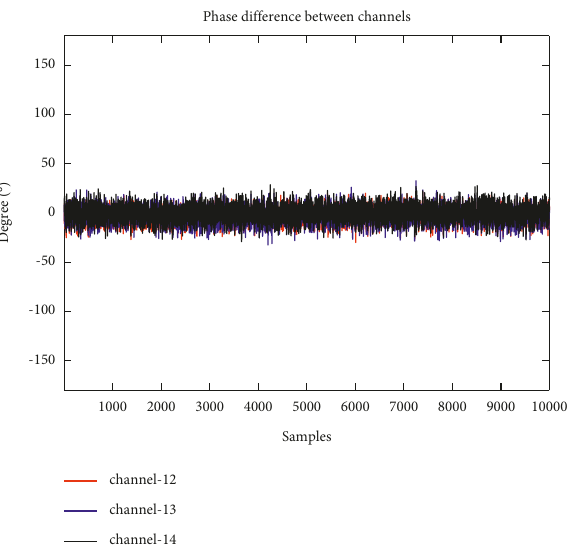
Figure 13: The phase difference between channels after correction.